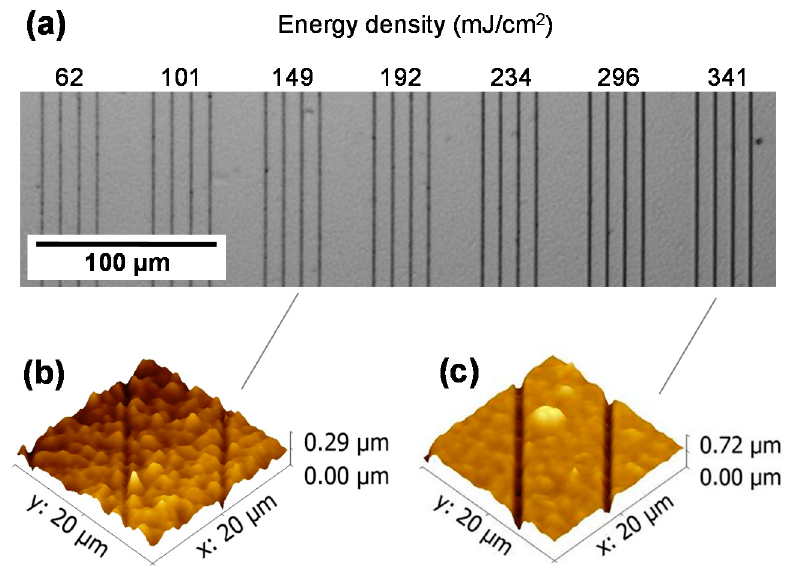
Figure 1. ( a ) Transmission optical microcopy of lines micromachined in chitosan film at a translation speed of 50 μ m/s and distinct energy densities. Three-dimensional AFM images of micromachined chitosan surface with energy densities of ( b ) 149 and ( c ) 341 mJ/cm 2 .